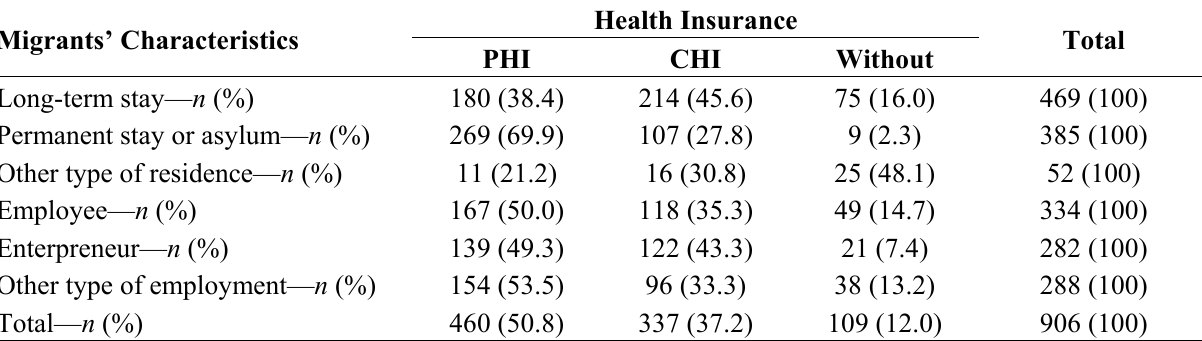
Table 1. Migrants by health insurance, type of residence and employment. PHI—public health insurance, CHI—commercial health